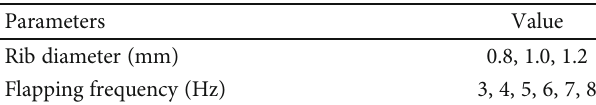
Table 2: Experimental